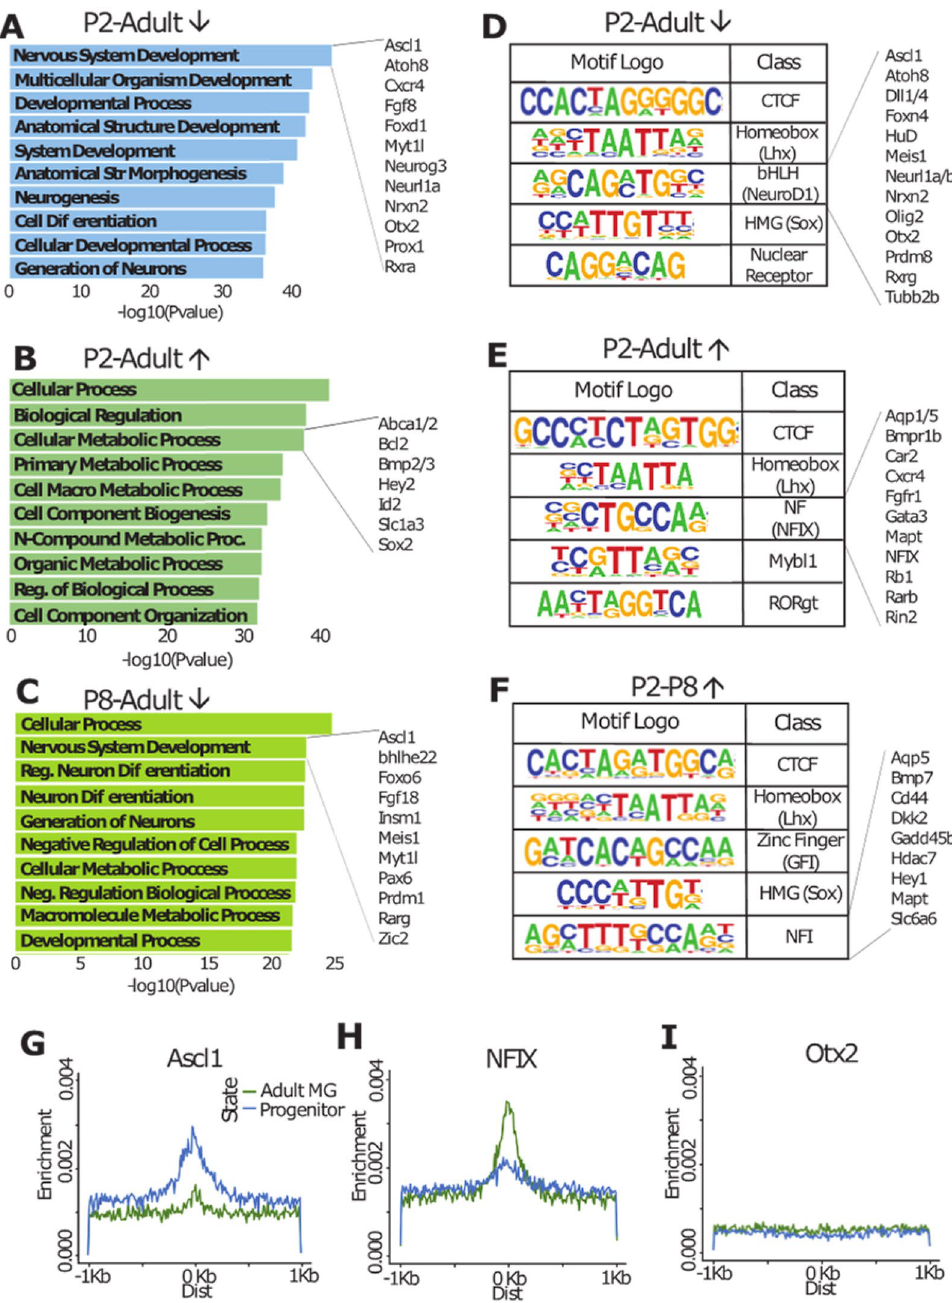
Figure 2. Cis-regulatory binding motifs differ in Müller glia development. ( A – C ) Gene ontology associated with accessibility changes ( A . LOA from P2 to adult, B . GOA from P2 to adult, C . LOA from P8 to adult). Genes of interest for key ontology categories shown at the right. ( D – F ) Predicted motif enrichment for accessibility changes ( D . LOA from P2 to adult [BEDOPS], E . GOA from P2 to adult [BEDOPS], F . GOA from P2 to P8 [DA]). Genes of interest for key motifs shown at right. ( G – I ). Central enrichment of motifs for progenitor- and adult MG-specific accessibility